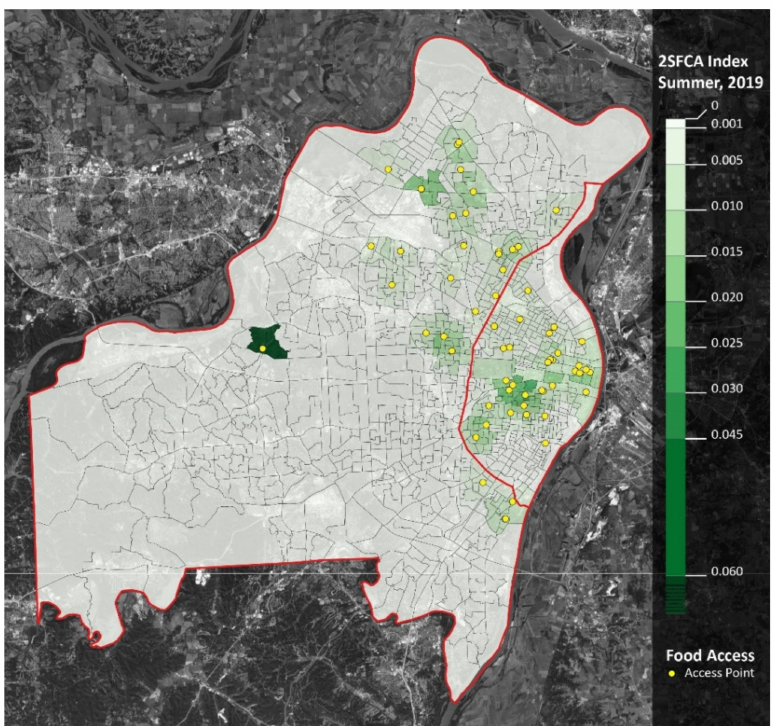
Figure 5. Meal accessibility (2SFCA Analysis): summer 2019. Notes: St. Louis City is the area east of the red line. St. Louis County is the area west of the red line. Yellow dots represent meal access points. Darker shades of green represent greater accessibility.